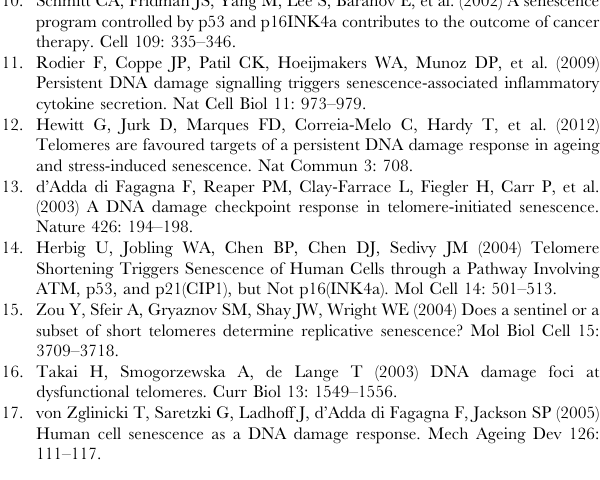
10 m m. Percentages in the picture show the fraction of ATM pS1981 or pS/TQ foci-positive cells 6 s.e.m. b. Bar graphs show the average number of ATM pS1981 or pS/TQ foci 6 s.e.m. per cell at the indicated time points (*** p-value , 0.001). Figure S2 Replicative senescence in WI-38 cells is associated with p16 activation. p16 protein level detection by immunofluorescence (a) or by immunoblotting (b) shows an increase in WI-38 senescent cells but not in BJ senescent cells. Scale bar, 100 m m. In b, proliferating BJ (BJ prol) and WI-38 (WI- 38 prol) cells are shown as negative control; OIS BJ cells were used as positive control for p16 accumulation. Vinculin was used as a loading control. Figure S3 Senescence establishment in WI-38 and BJ fibroblasts detected by SA- b -gal staining and BrdU incorporation assay. WI-38 and BJ senescent cells (WI-38 sen and BJ sen respectively) show low level of BrdU incorporation (24 hours pulse) compared to the pre-senescent (pre-sen) and proliferating ones (prol) and an increase in SA- b -gal activity. Error bars represent s.e.m. Figure S4 Replicative senescent WI-38 cells tend to lose DDR activity with time. Representative pictures show DDR foci in the form of c H2AX followed over time, up to 1 month from the entry into senescence (early senescent cells); whereas senescent BJ maintain the DDR, WI-38 tend to lose it with time. Scale bar,